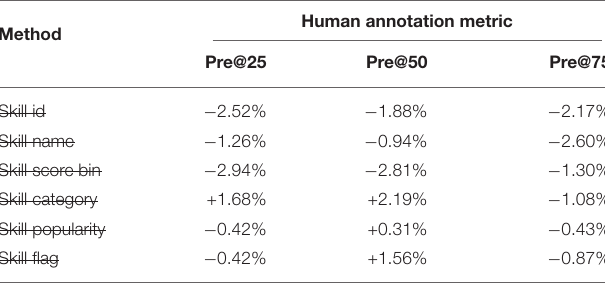
TABLE 3 | Summarization of ablation study. It reports normalized relative difference when removing each feature from baseline model. Human annotation Method